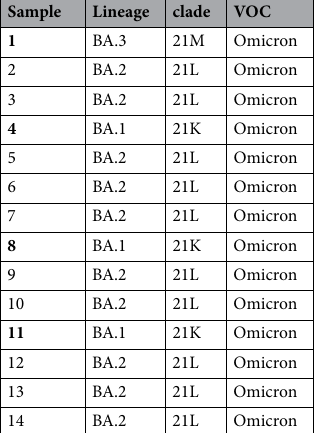
Table 5. Results for NGS sequencing of 14 randomly selected RNA specimens. Samples with the 69–70 amino acid deletion in the spike protein, presenting the S Gene Target Failure (SGTF) detection pattern in the TaqPath COVID-19 assay, are marked in